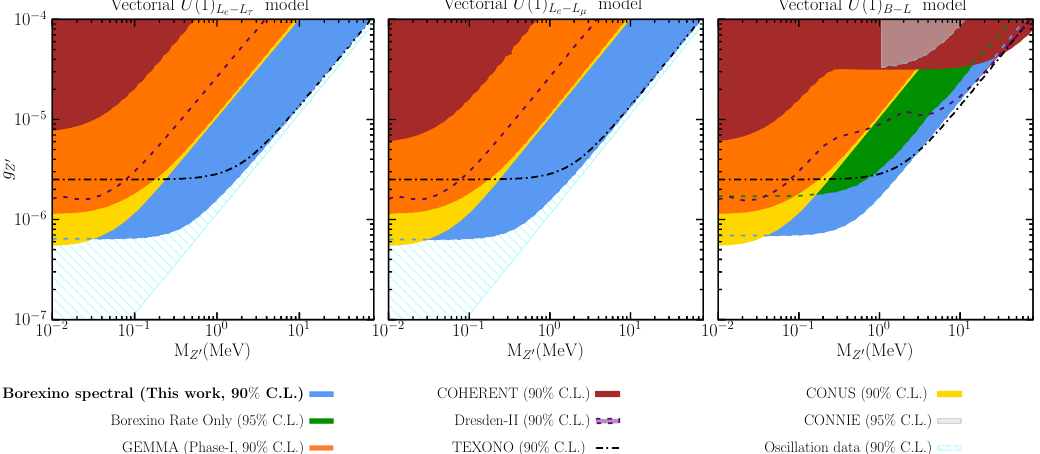
Figure 5 . Bounds from our analysis of Borexino Phase II spectral data (at 90% CL for 1 d.o.f., using two-sided intervals, i.e., ∆ χ 2 = 2 . 71 ) on the vector mediators associated to a new U(1) 0 symmetry, as indicated in the top label for each panel. Our results are compared to our derived bounds from GEMMA [45 , 50] , TEXONO [50 , 51] , COHERENT [15 , 16 , 52] , and Dresden-II reactor experiment [14 , 15] , as well as those derived from a global fit to oscillation data [50] , all of them obtained with the same statistical criterion. We also show the bounds from CONNIE [13] (95% CL) and CONUS [54] (90% CL) which we have obtained applying an overall rescaling factor to their published bounds on a universally coupled vector (see text for details). For the B − L model, the line labelled “Borexino Rate Only” shows the approximate bound derived (at 95% CL, 1 d.o.f., for one-sided intervals) in ref. [26] (see also ref. [27]